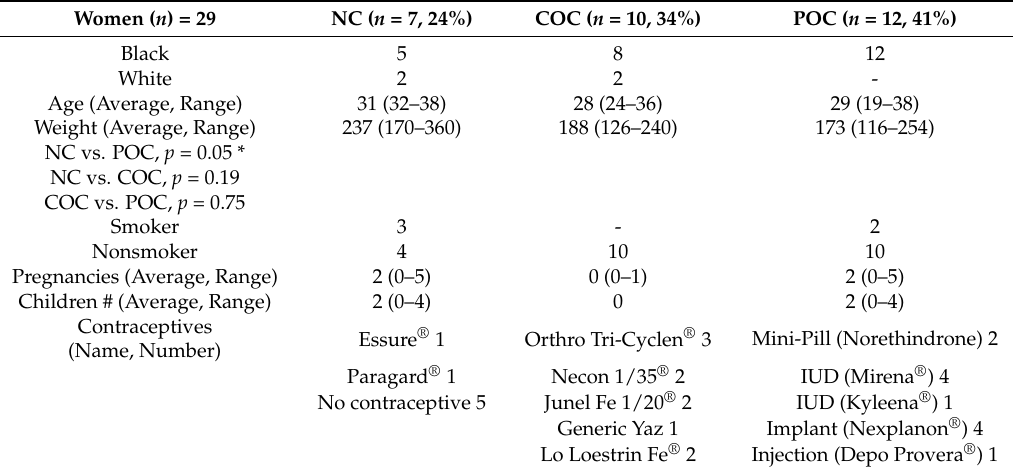
Table 1. Participant